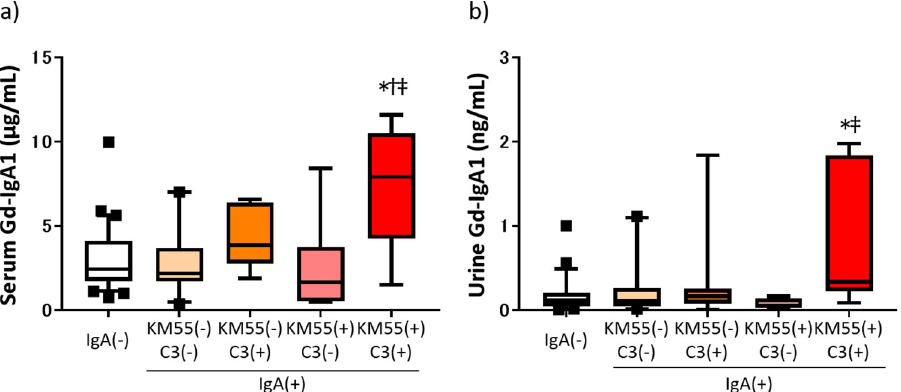
Fig 2. Serum and urinary Gd-IgA1 levels in the subgroups. a) Serum Gd-IgA1 levels. b) Urinary Gd-IgA1 levels. � p < 0.05 vs IgA( − ) group, † p < 0.05 vs. KM55( − )C3( − ) group, ‡ p < 0.05 vs KM55(+)C3( − ) group by Dunn’s multiple comparison post-hoc correction. IgA, immunoglobulin A; Gd-IgA1, galactose-deficient IgA1; IgA( − ), IgA-negative group; IgA(+), IgA-positive group; KM55( − ), KM55-negative group; KM55(+), KM55-positive group; KM55( − )C3( − ), KM55-negative/C3-negative group; KM55( − )C3(+), KM55-negative/C3-positive group; KM55(+)C3( − ), KM55-positive/C3-negative group; KM55(+)C3(+), KM55-positive/C3-positive